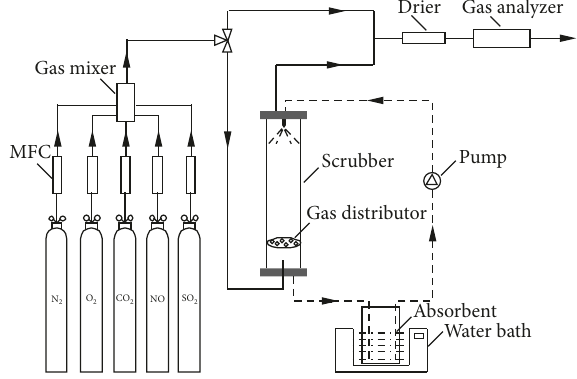
Figure 1: Schematic diagram of the experimental